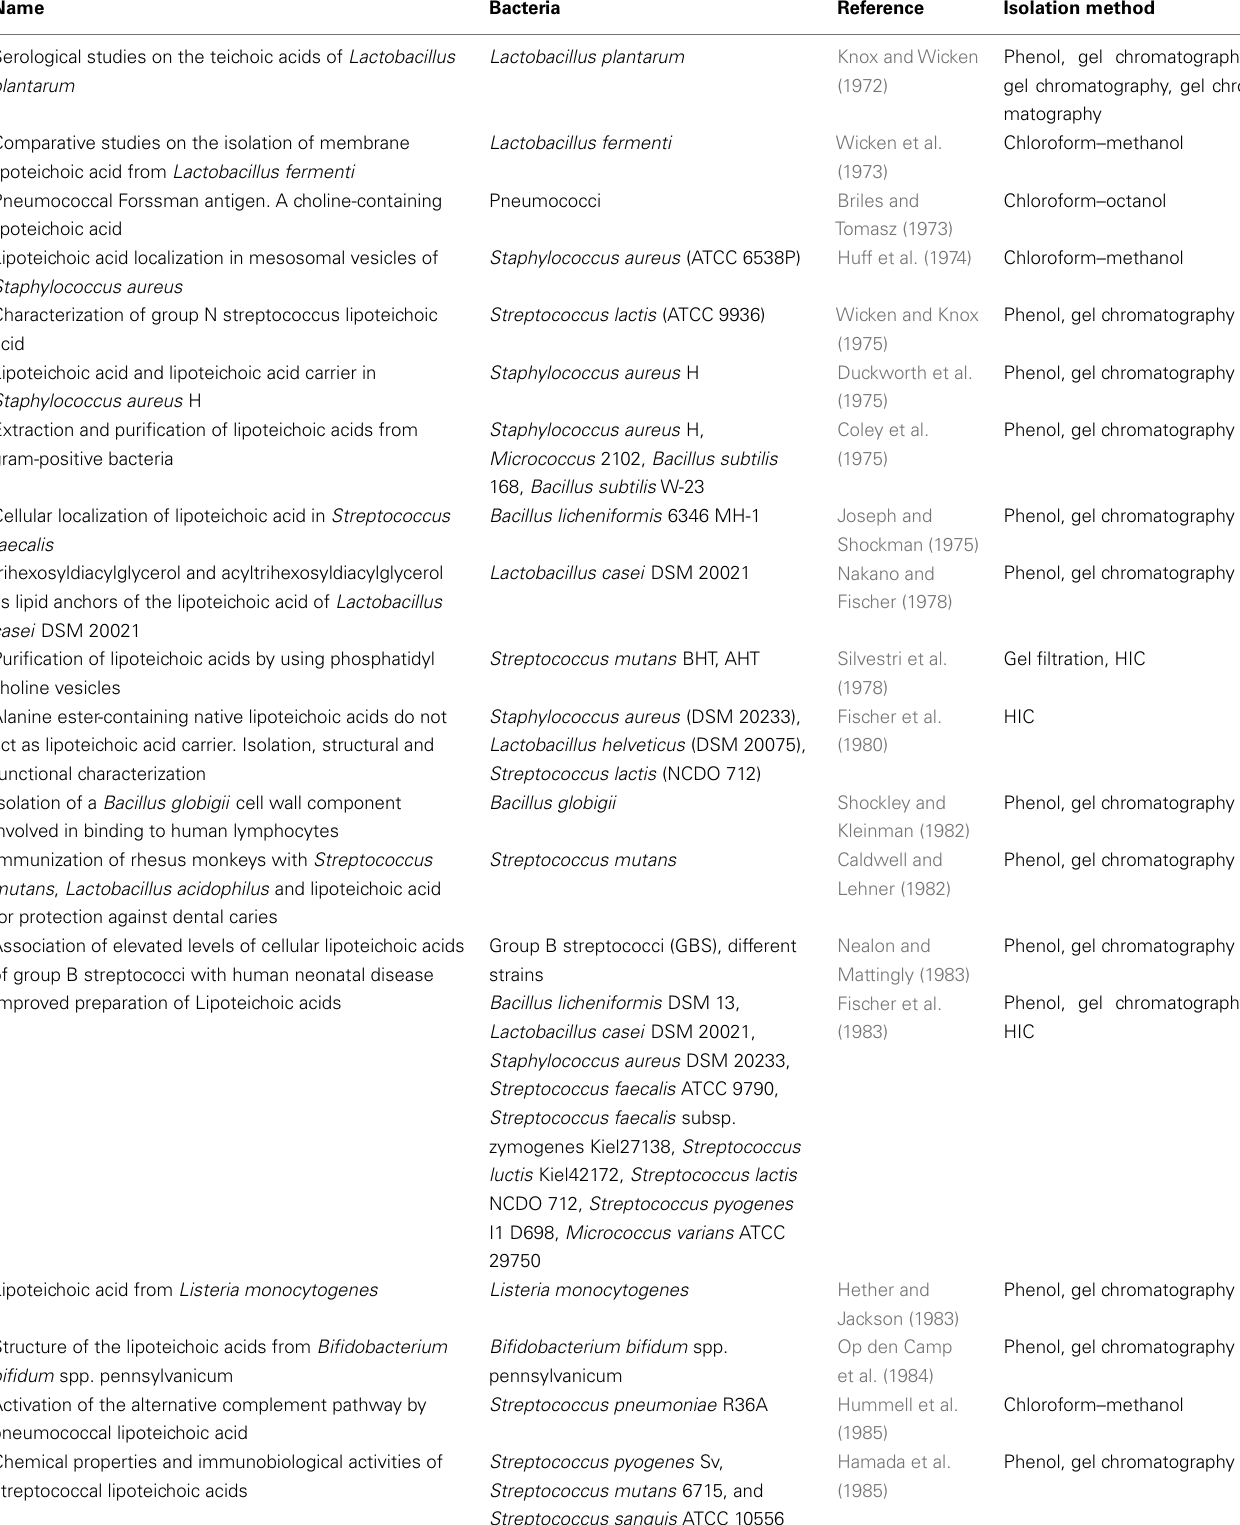
Table 1 | List of publications for isolation of LTA after application of decision tree